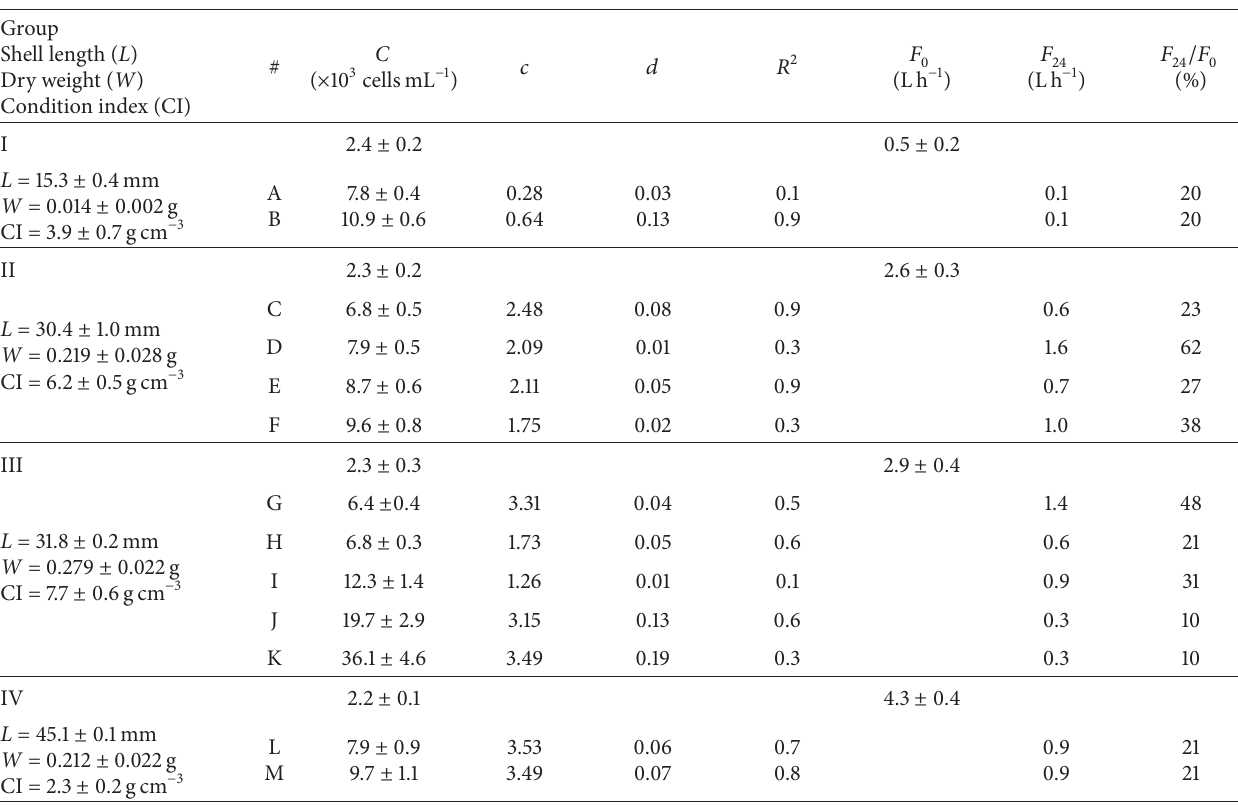
Table 1: Mytilus edulis . Filtration rate ( 𝐹 0 ) initially measured by the fluorometer controlled apparatus (FCA) on 4 groups of mussels under optimum conditions (about 2,300 cells mL − 1 ), and estimated filtration rate ( 𝐹 24 ) of the same mussels after 𝑡 = 24 h exposure to different constant algal ( Rhodomonas salina ) concentrations ( 𝐶 , cells mL − 1 ). The coefficients 𝑐 and 𝑑 , and coefficient of determination ( 𝑅 2 ) were obtained from exponential curve-fits according to the equation 𝐹 24 = 𝑐 × exp (−𝑑 × 𝑡) for data shown in Figure 5 (#). Condition index ( CI ) = 𝑊 (g dry weight of soft parts)/ 𝐿 (cm) 3